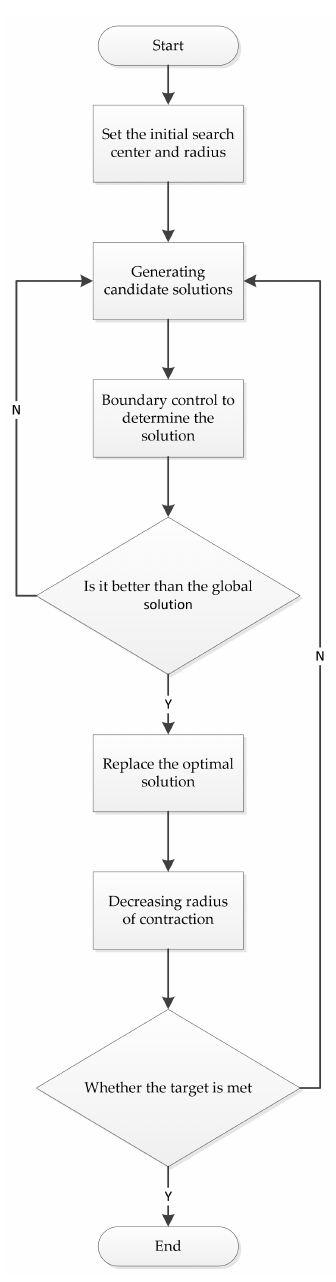
Figure 3. The flow chart of VS